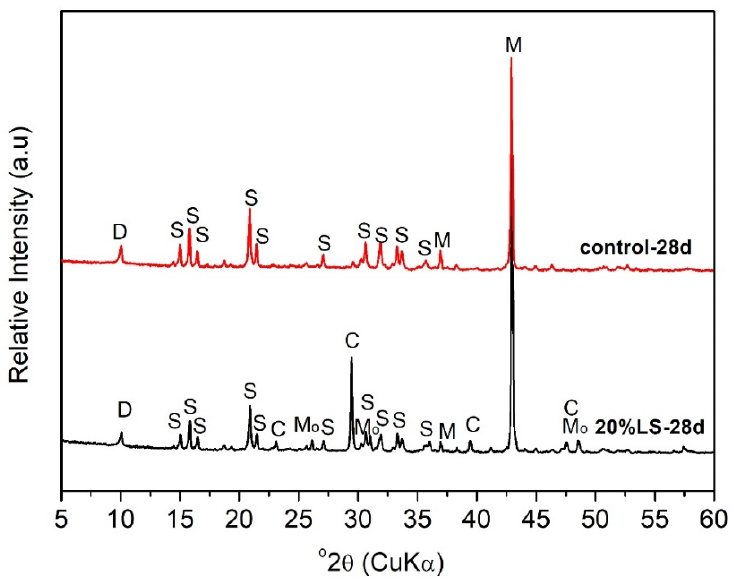
Figure 9. X-ray diffraction (XRD) spectrum for MAPC samples containing 20% limestone fines at a